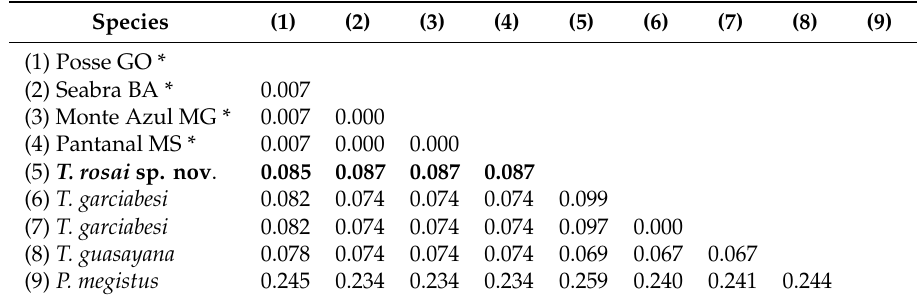
Figure 11. The tree obtained by Bayesian Inference for the concatenated genes COI, cyt b, 28S, 16S and ITS-1. The numbers in the nodes represent the bootstrap values. Table 3. Genetic distance based on cyt b mitochondrial gene. In bold we present the Genetic distance between T. rosai sp. nov. and T. sordida sensu stricto .